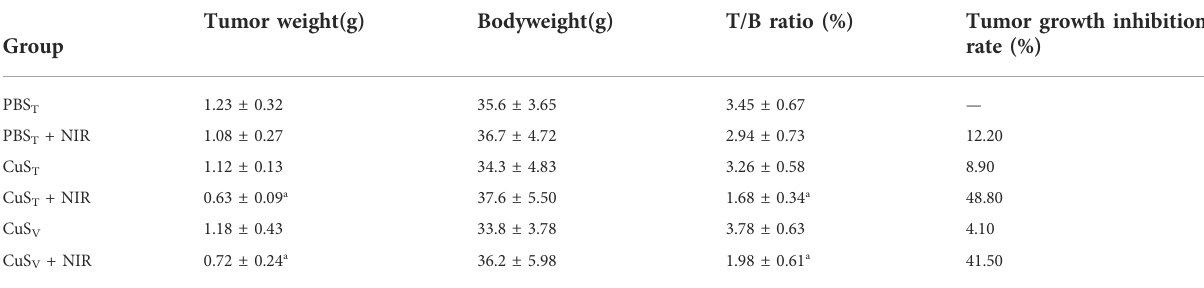
TABLE 1 Comparison of tumor weight, tumor weight/body weight ratio, and tumor growth inhibition rate in each group (N = 6 per group).